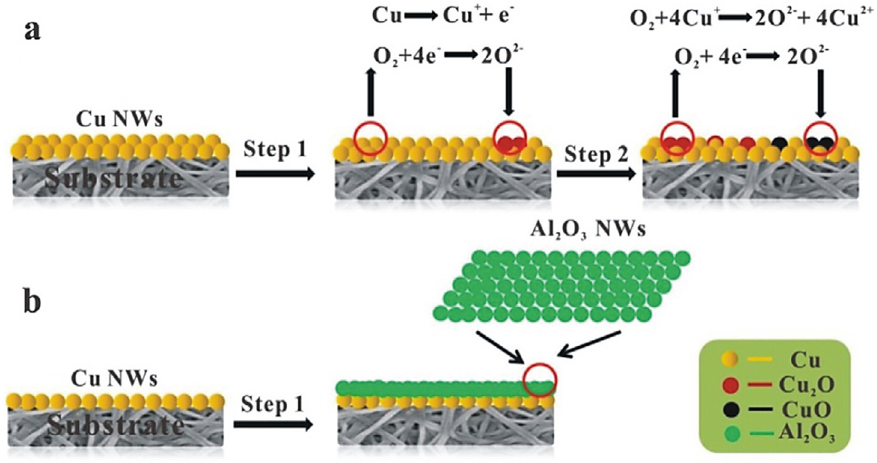
Figure 17. The schematic diagram of the anti-oxidation mechanism of the Cu nanostructure layers ( a ) in the absence and ( b ) presence of Al 2 O 3 layers. Reprinted from [ 350 ] . Copyright 2016, with permission from Elsevier Ltd.